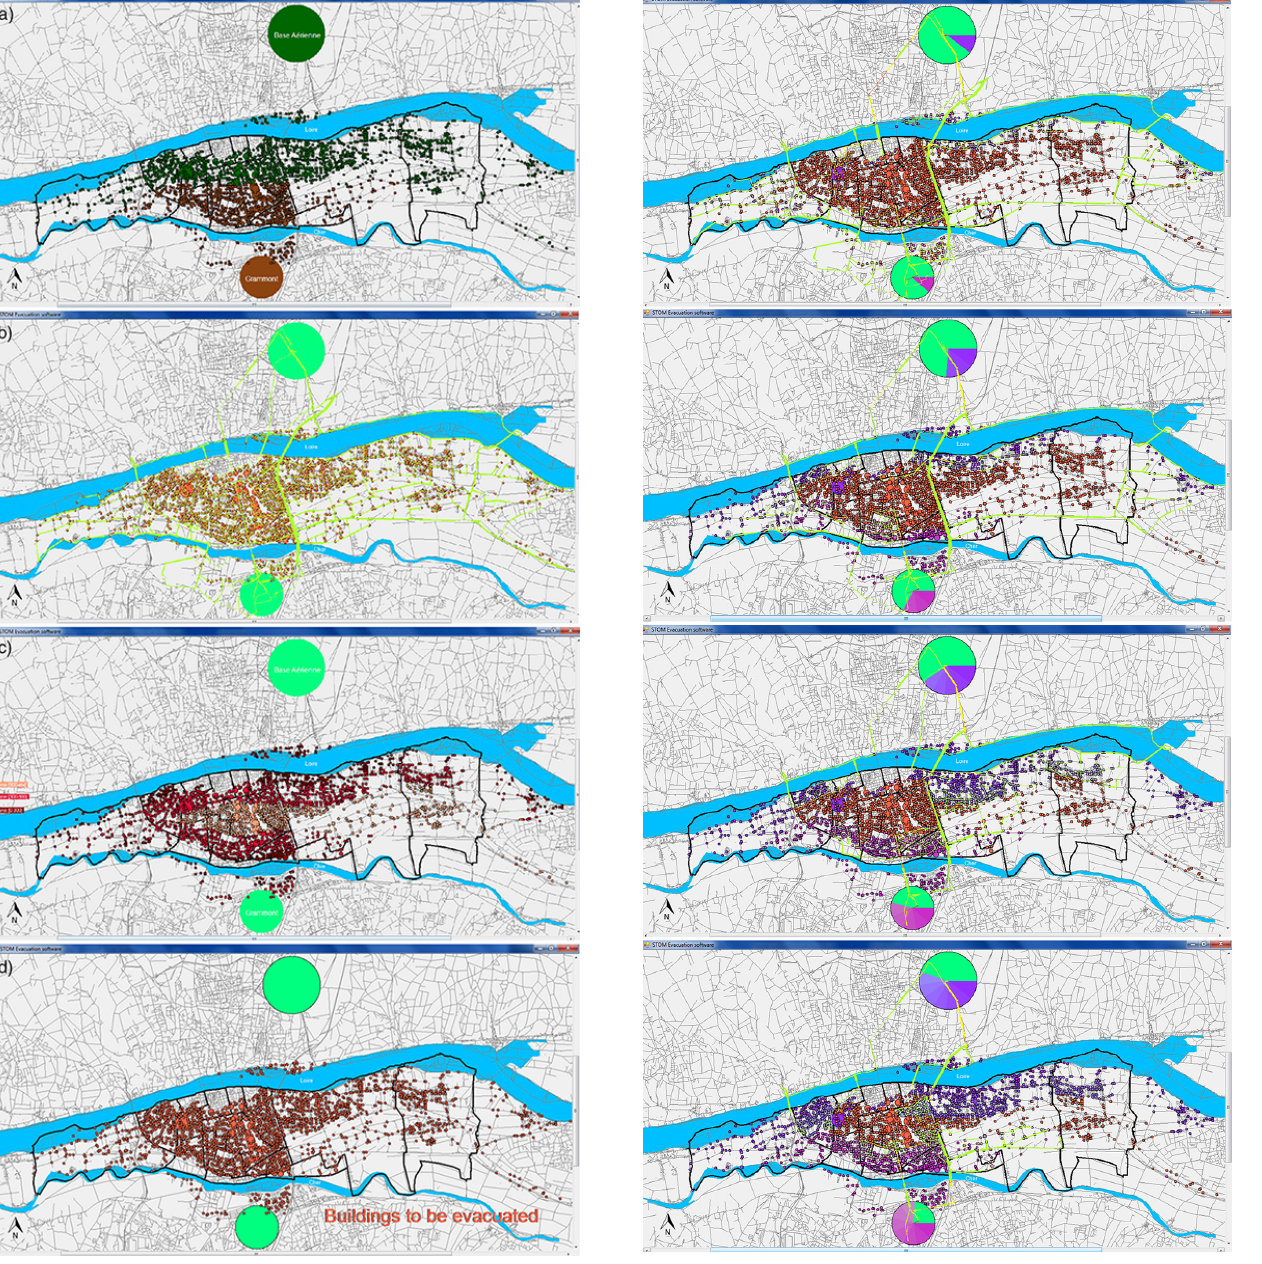
Figure 10. The preliminary steps for the construction of evacuation plan II: (a) grouping of original buildings and association of build- ings (groups of original buildings) to safety points. (b) Calculation of three best paths between buildings and safe points. (c) Establish- ment of priorities list according to destruction zones. (d) Buildings to be evacuated.